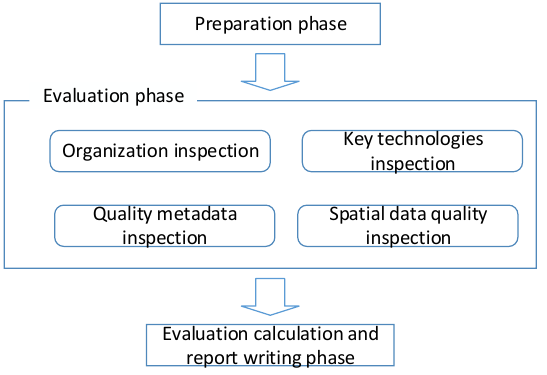
Figure 1 . the data quality evaluation